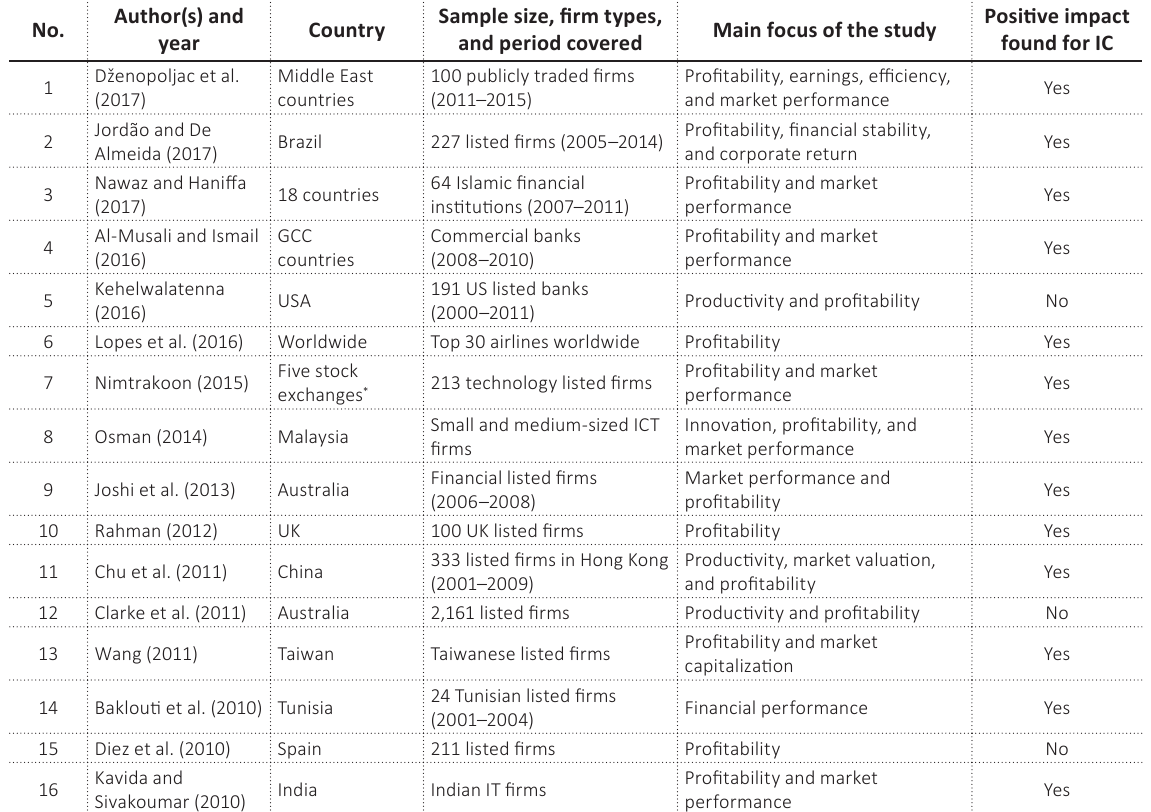
Table 1. Studies on the association between IC and FFP